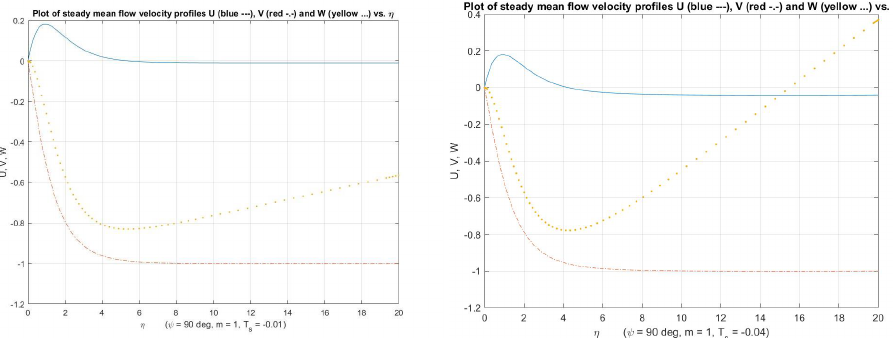
Figure 3. Plot showing the mean flow profile U , V and W for ψ = 90, T s = − 0.01 ( left ) and − 0.04 ( right ).